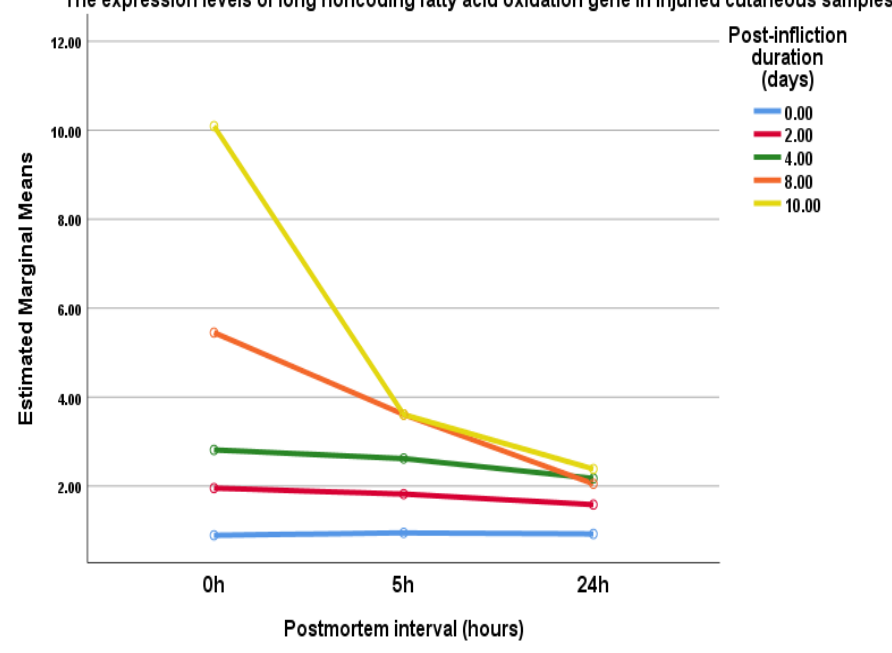
Figure 4. The expression of lncFAO gene in 0, 2, 4, 8, 10 days after wound infliction at different postmortem intervals (0, 5th, and 24th h).